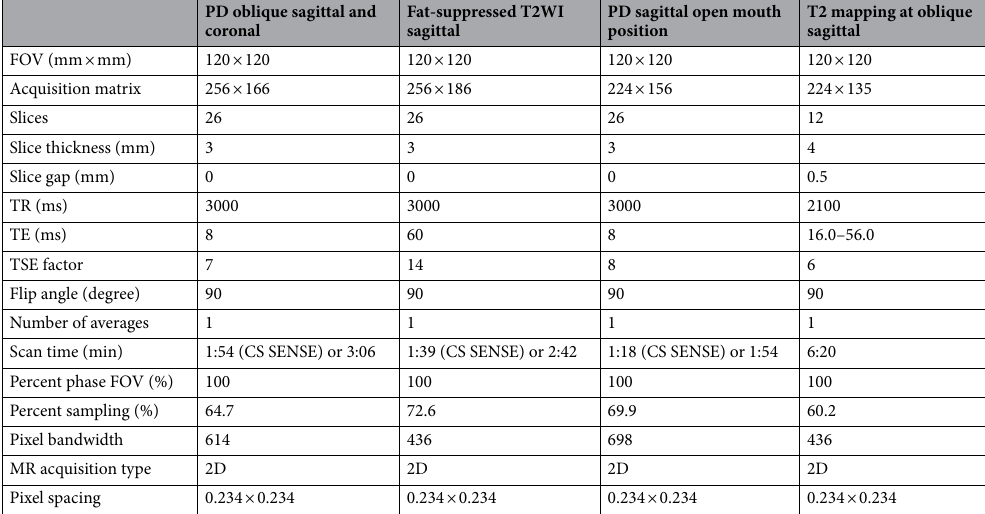
Table 4. Scan parameters. FOV, a field of view; TR, repetition time; TE, echo time; TSE, turbo spin-echo; PD, proton density; CS SENSE, compressed